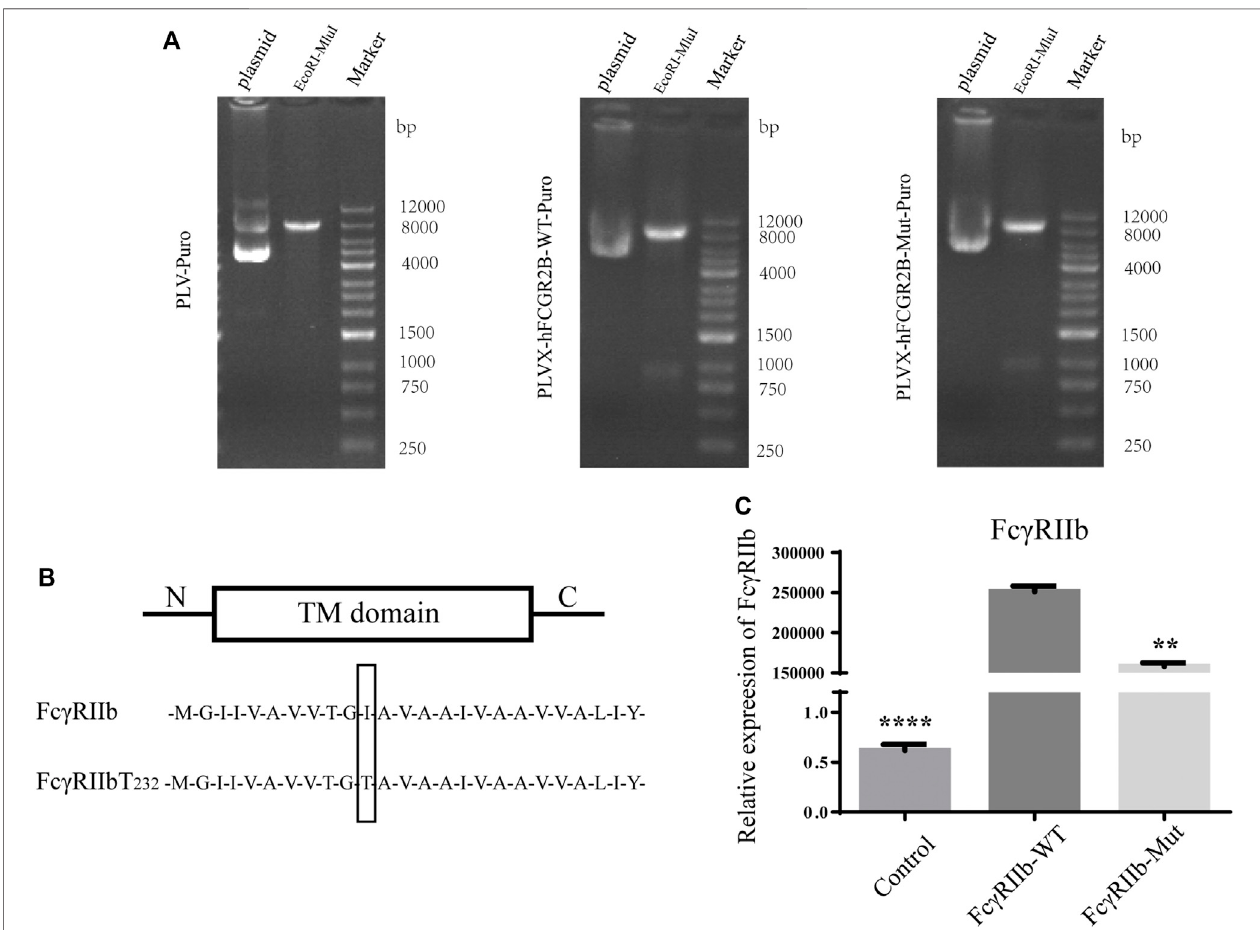
FIGURE 2 | Design of the Fc γ RIIb-mutant cell lines. (A) Plasmid constructs: The human Fc γ RIIb coding gene was ampli fi ed by PCR and inserted into PLVX by EcoRI and MluI digestion sites. Obvious bands could be seen in 8000-bp and 1000-bp fragments, indicating that the 951-bp sequence of the target gene was successfully inserted. (B) Fc γ RIIb-Mut and Fc γ RIIb-WT encoded transmembrane proteins. Variants exist at locus 232. (C) Detection of plasmid transfection effect by qRT-PCR. The experiments were repeated three times and analyzed using one-way ANOVA. ** p < 0.01, **** p < 0.0001 vs. the WT group.